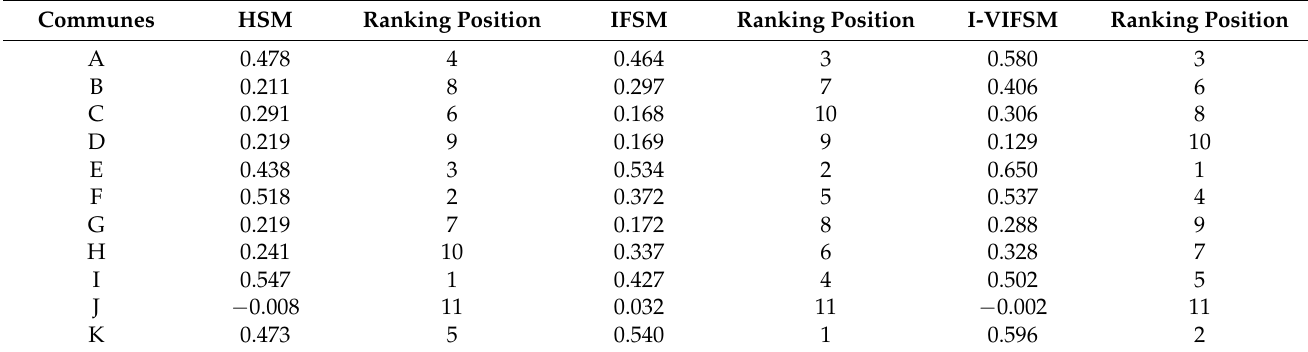
Table 15. The results of the comparative analysis of the synthetic measures Hellwig’s synthetic measure (HSM), Intuitionistic Fuzzy Synthetic Measure (IFSM), and Interval-Valued Intuitionistic Fuzzy Synthetic Measure (I-VIFSM).